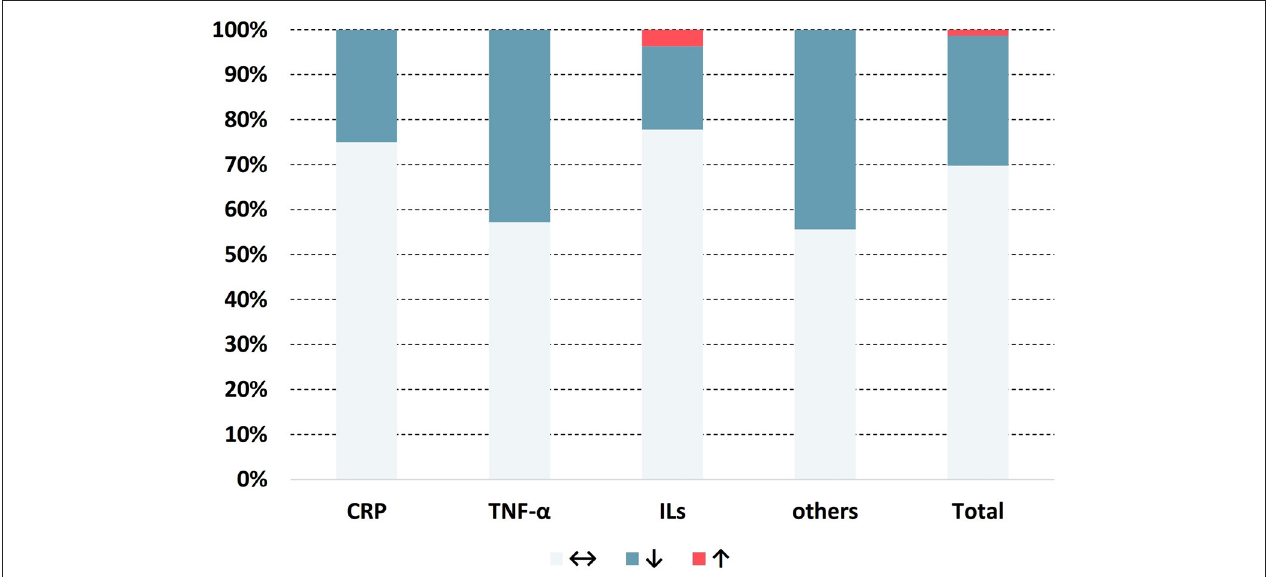
FIGURE 2 | Distribution of the change in direction for anti-inflammatory markers. ↔ : no significant change; ↓ : significant decrease ( p < 0.05); ↑ : significant increase ( p <